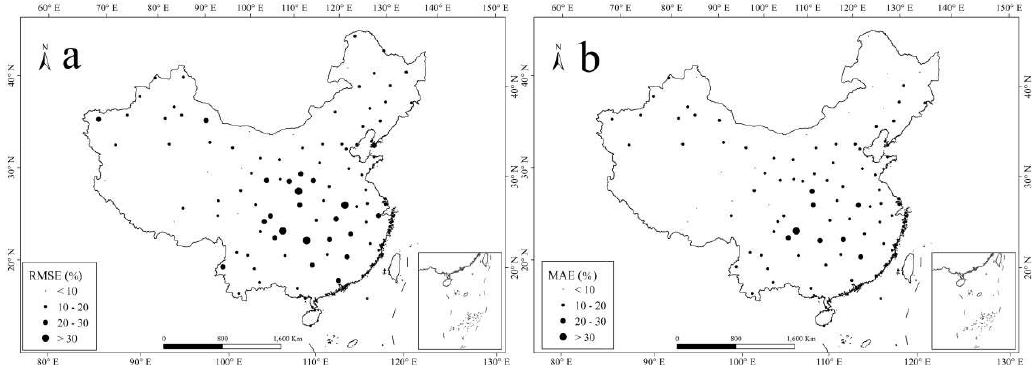
Figure 10. Spatial distribution of the RMSE and MAE of YHM over Mainland China ( a for RMSE, b for MAE).